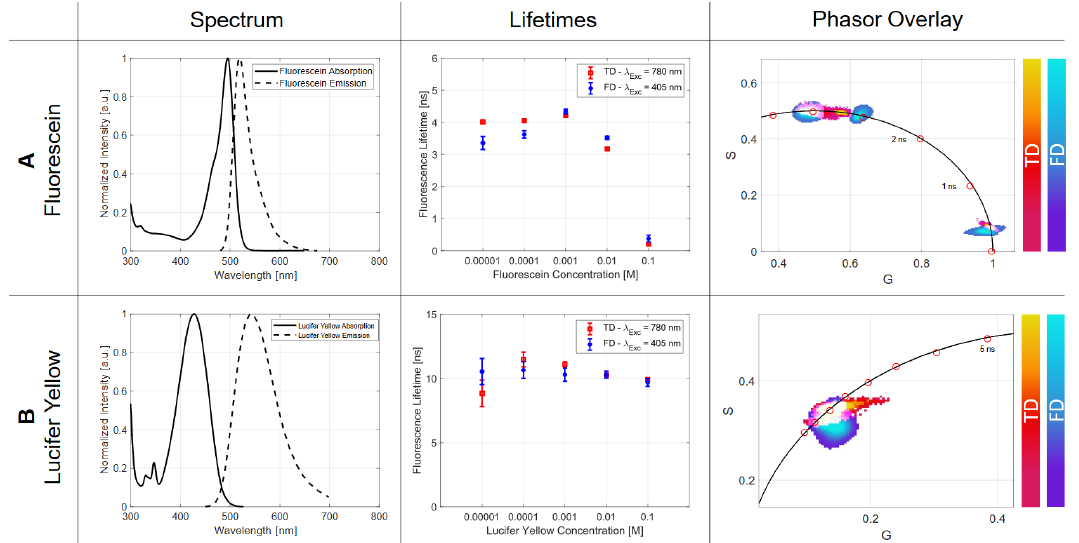
Figure 2. In this figure, the spectral properties of the two fluorophores used, fluorescein and lucifer yellow, are shown in ( A ) to check if the concentration could lead to an influencing parameter while measuring lifetime values, the spectral overlap must be observed. Fluorescein shows a relatively big spectral overlap compared to lucifer yellow. With the graphs in ( B ), the lifetimes of the TD are shown in red and the ones of the FD are in blue. For fluorescein, the lifetime change for high concentrations can be seen clearly, whereas the results of lucifer yellow stay nearly the same. The last column presents this relation in the phasor plot for the TD, as well as for the FD